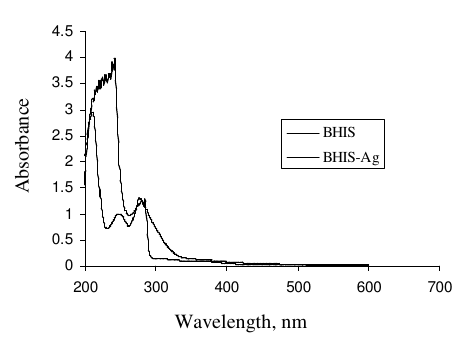
Figure 1. Absorption spectra of BHIS-Ag complex.